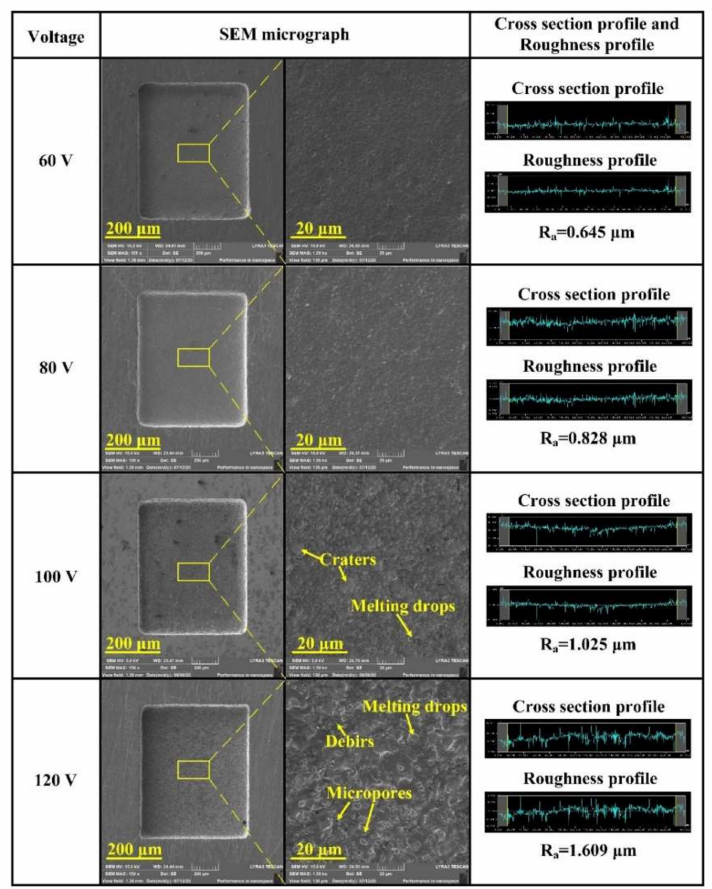
Figure 8. E ff ect of di ff erent machining voltages on surface roughness and scanning electron microscope (SEM) micrographs of the microcavities